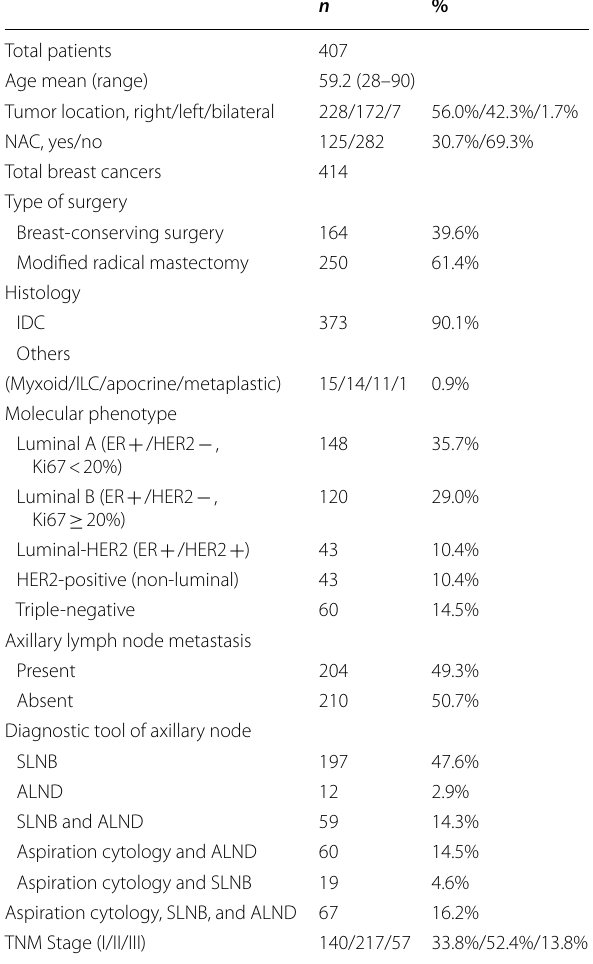
Table 1 Patient and tumor